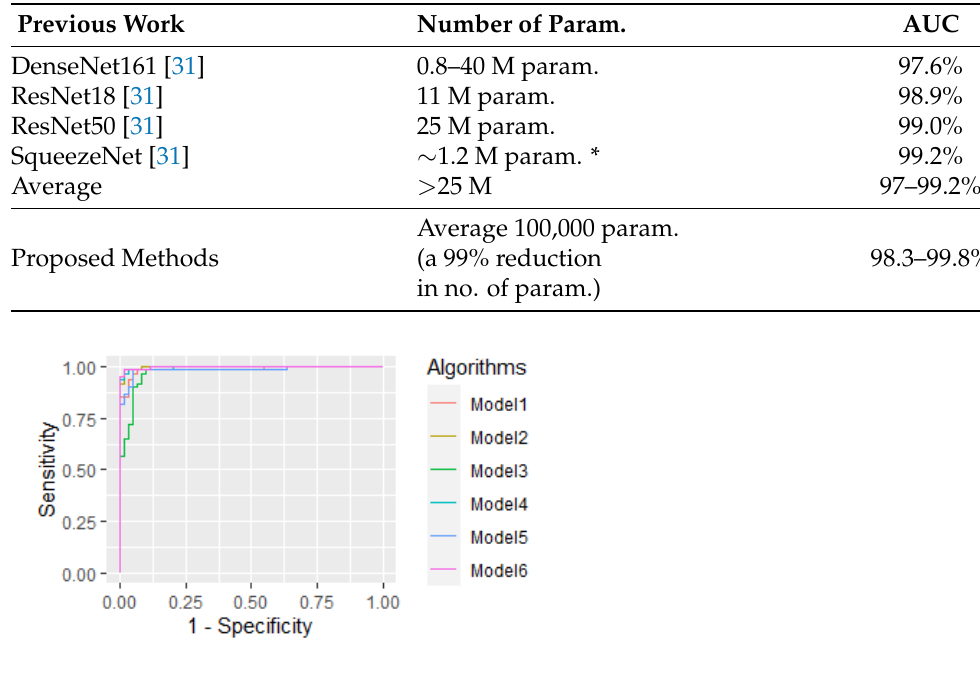
Figure 8. The AUC path for all six models in the proposed work. These models are listed in Table 10 with detailed information including the parameters from each layer and the out-of-sample prediction